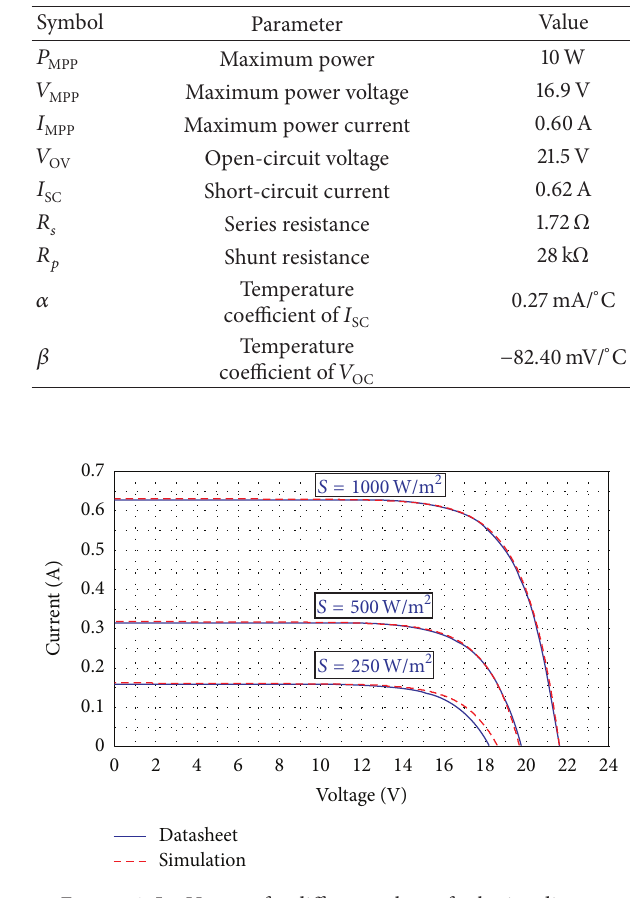
Figure 4: 𝐼 × 𝑉 curve for different values of solar